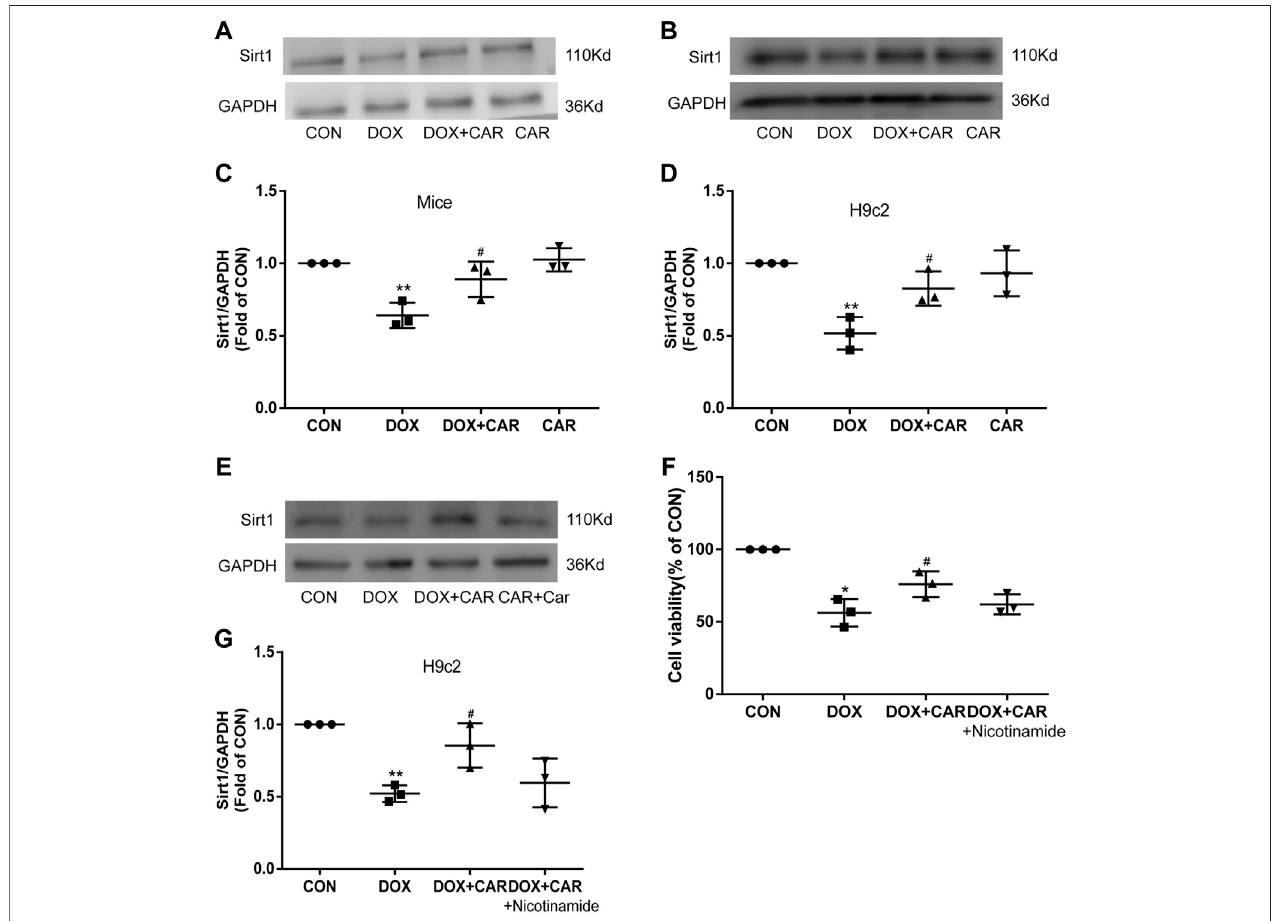
FIGURE7| Sirt1wasinvolvedinthecardioprotectiveeffectofCARagainstDOX-inducedcardiotoxicity. (A) :RepresentativewesternblotsofSirt1incardiactissues of mice, (B) : Representative western blots of Sirt1 in H9c2 cells, (C) : Histogram representing the quantitative analysis of Sirt1 in cardiac tissues of mice, (D) : Histogram representing the quantitative analysis of Sirt1 in H9c2 cells, (E) : Representative Western blots of Sirt1 in H9c2 cells treated with the inhibitor, (F) : The cell viability measured by CCK-8, (G) : Histogram representing the quantitative analysis of Sirt1 in H9c2 cells treated with inhibitor. Quantitative data are means ± SEM (n = 3). * p < 0.05, ** p < 0.01 vs. CON; # p < 0.05 vs.